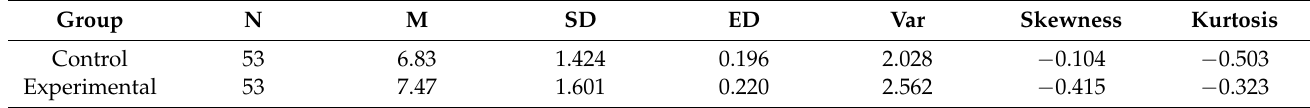
Table 2. Descriptive statistics of post-test data.